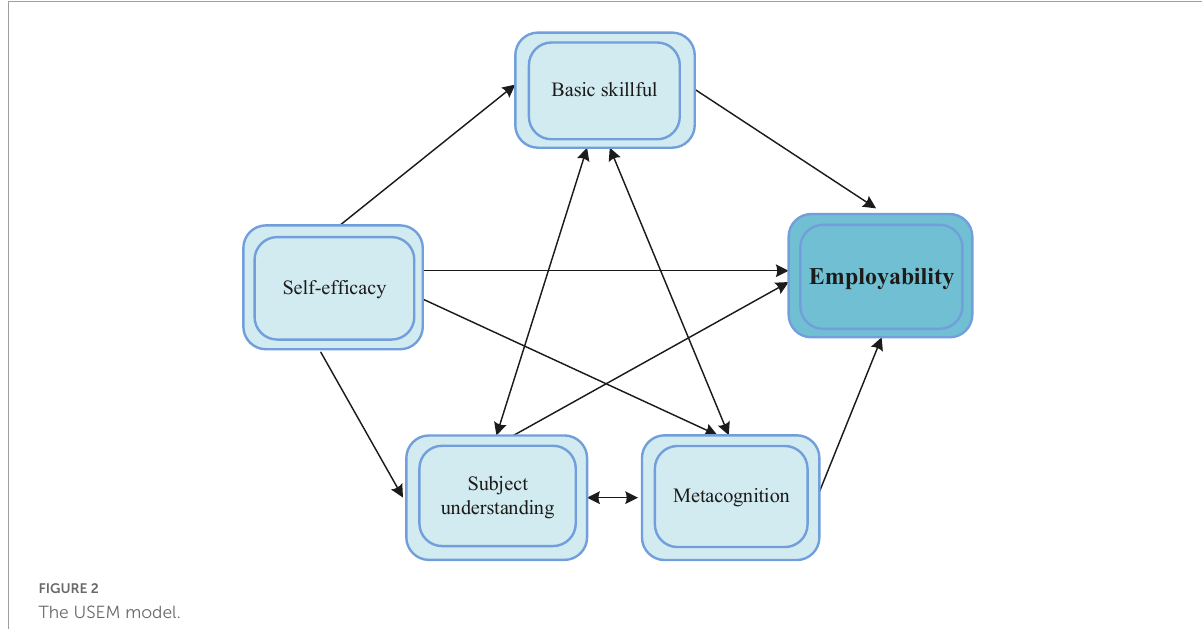
FIGURE2 The USEM